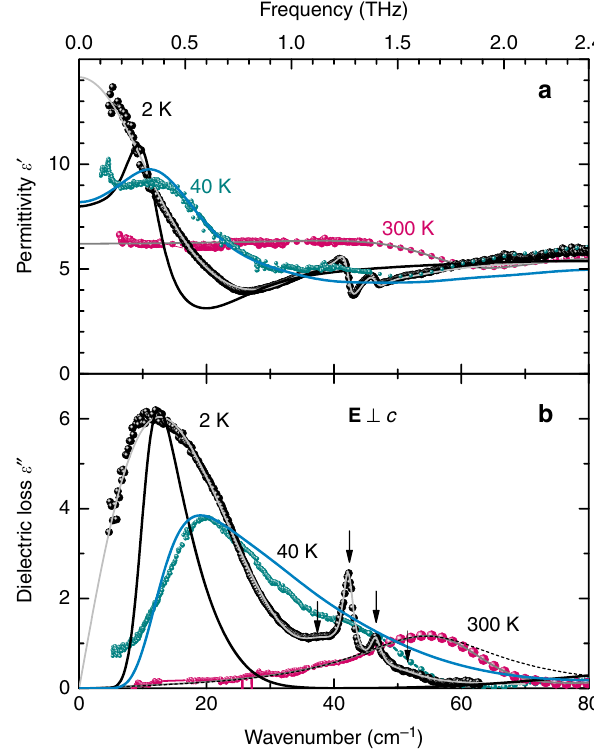
Figure 3 | Temperature evolution of the dielectric constant and losses. ( a , b ) Terahertz spectra of the real and imaginary parts of the dielectric permittivity (dots) of a hydrated beryl crystal measured for E > c at different temperatures as indicated. The grey solid lines are fits to the data by a sum of equation (3) (coupled oscillators) for the broad soft mode and equation (2) (damped Lorentzians) for the narrow resonances above 40cm (cid:2) 1 , shown by arrows in b . The dashed line illustrates a fit with a single Lorentzian term of the spectra at T ¼ 300K. Black and blue solid lines show the fits according to the six-well librator-rotator model, as described in the